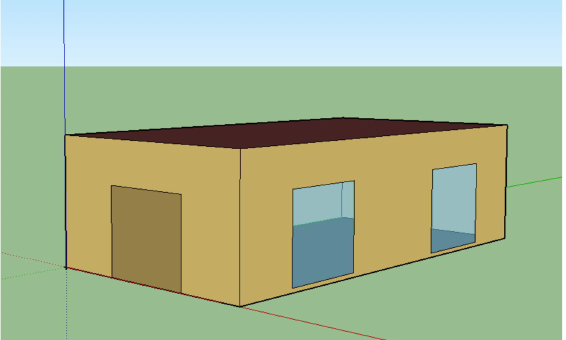
Figure 3. A 3D view of the highly occupied room considered in this